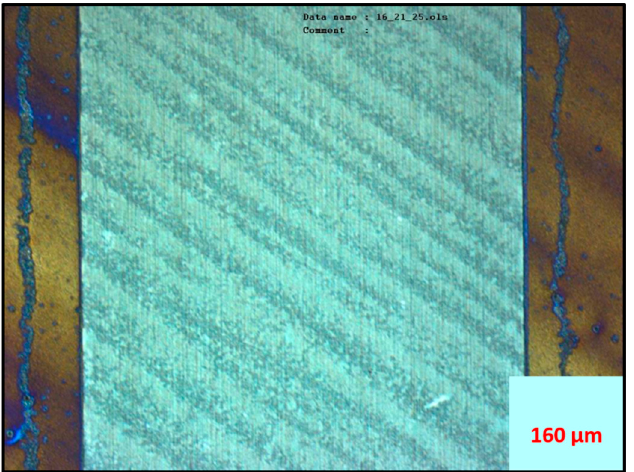
Figure 2. Ablated area obtained by 2-step P2 laser ablation over mTiO 2 +G/perovskite/PTAA stack.